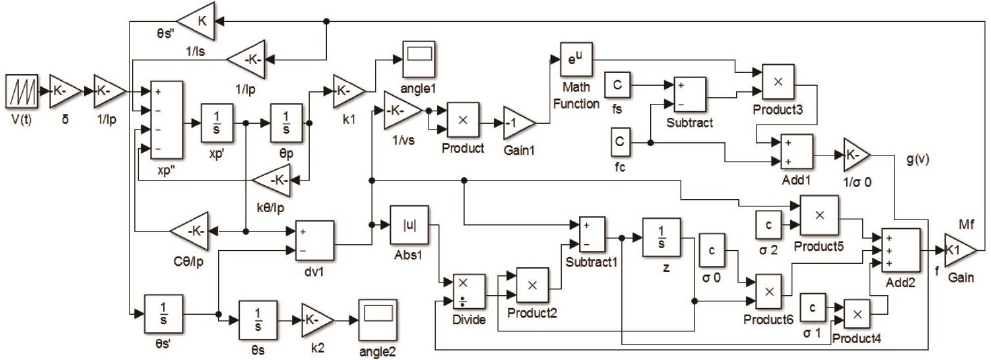
Figure 4. Dynamic simulation block of the rotary motor.